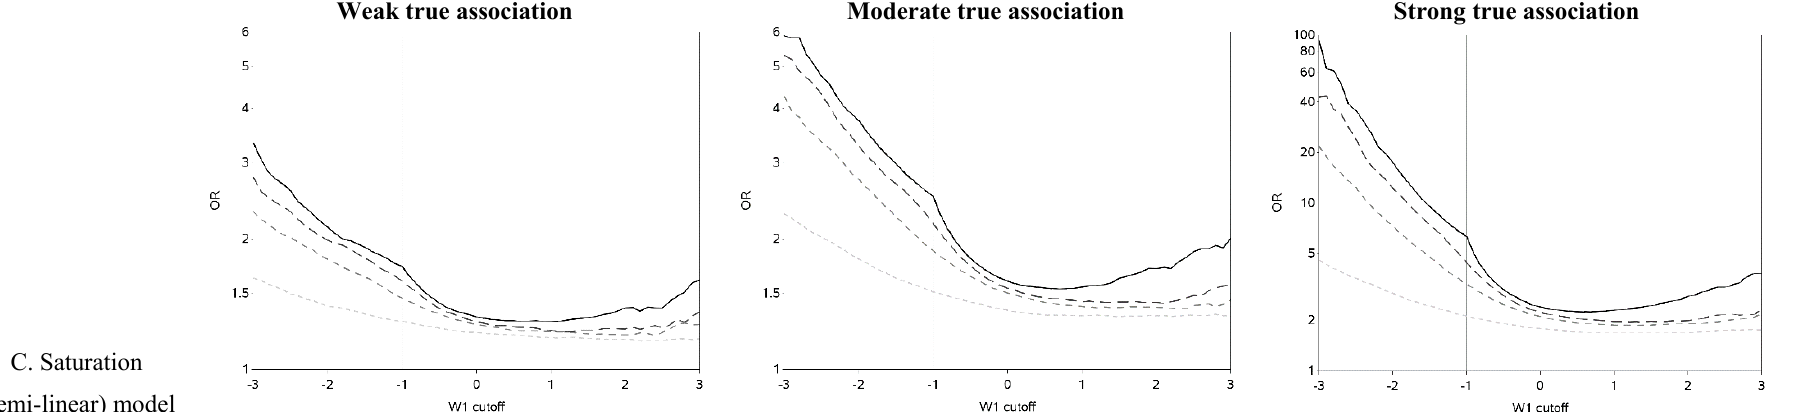
Figure A1. Odds ratios for different cutoffs (between mean ±3 standard deviations) used to dichotomize a mismeasured exposure (W 1 ) (all scenarios for Figure 2). The X 1 cutoff was changed from −3.0 to 3.0 in increments of 0.1. Exposed W 1 ≥ cutoff, referent: W 1 < cutoff. The vertical reference line for the semi-linear models is the inputted inflection